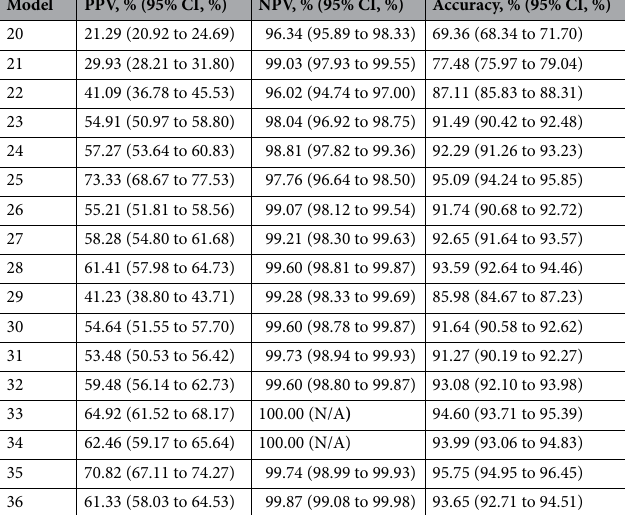
Table 2. Effects of prevalence on screening performance of each model: United States (prevalence, 10.06%). CI confidence interval, PPV positive predictive value, NPV negative predictive value, N/A not applicable.